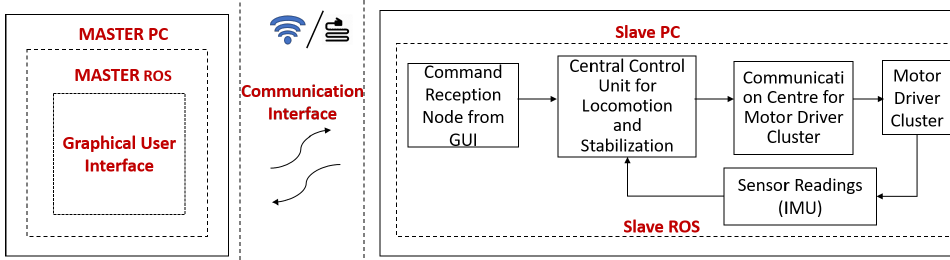
Figure 5. Communication architecture of the